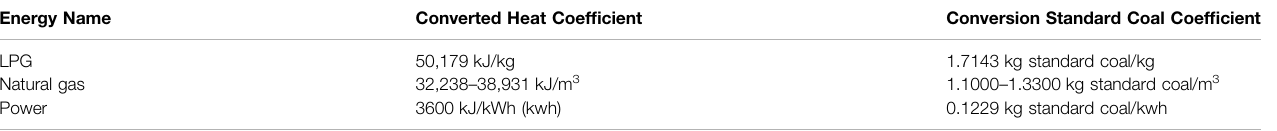
TABLE 1 | nergy conversion coef fi